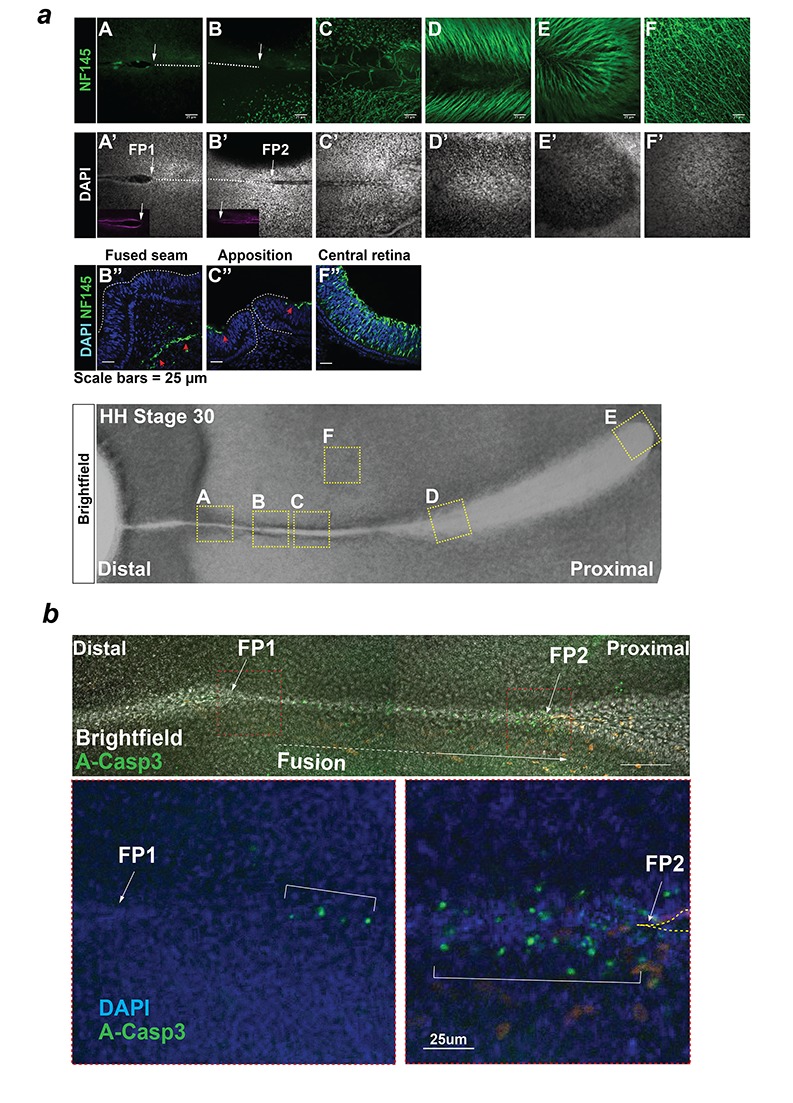
Analysis of axonal processes and apoptosis during chick OFC.(a) Anti-Neurofilament immunostaining (NF145, Neurofilament medium; Top panels) in the OFM during active fusion. NF145 immunoreactivity (green) was absent from the distal and medial OFM but was observed in the proximal region at the developing pecten and optic nerve. Immunostaining on sections (middle panels) taken at the fused seam, the apposed OFM, and at the central retina confirmed the absence of axons in epithelial tissues at the open OFM and the nascently-fused OFM. Panel labels correspond to positions indicated in the HH.St30 flat-mount brightfield image (Bottom). (b) Top: Combined bright-field and fluorescence confocal imaging (Z-stack projections) of whole mount anti-activated Caspase-3 immunostaining in a HH.St30 fissure showed positive foci in the fused seam at a ~ 100 μm from the static FP1, and multiple positive foci within the fused seam >100 μm FP2. Below: Enlarged images of FP1 and FP2 from (b) counterstained with DAPI highlighted the enrichment for A-Casp3 foci at FP2 (open margin is indicated by hatching).